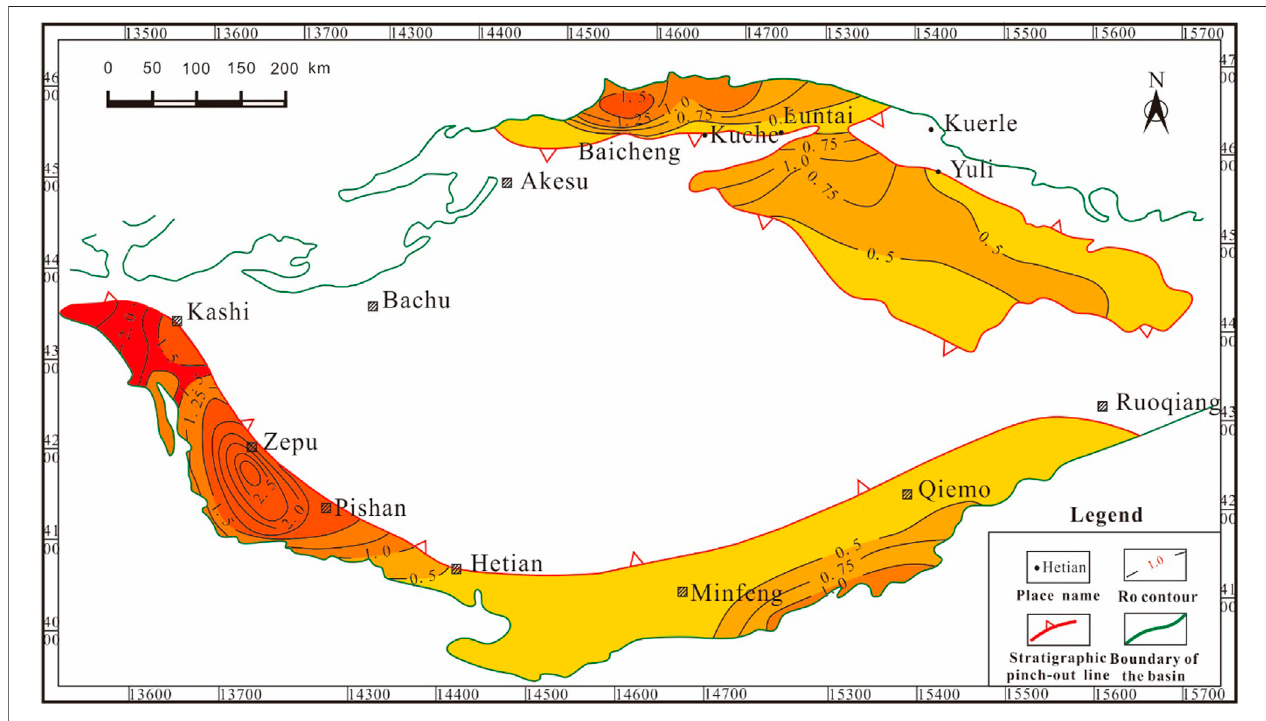
FIGURE 7 | Contour map of Ro of Lower Jurassic in the Tarim